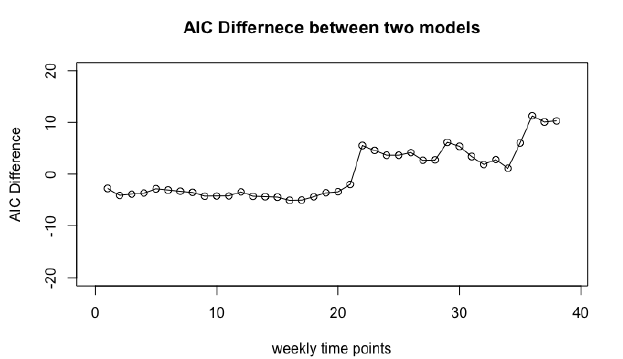
Figure 3. AIC difference ModelI AIC − ModelII AIC over 38 weeks of